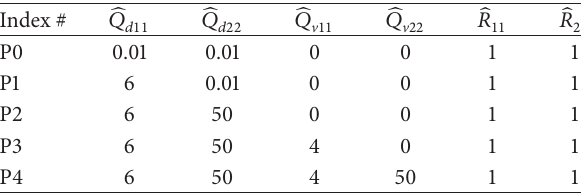
Table 1: Weightings for five different performance indices in form